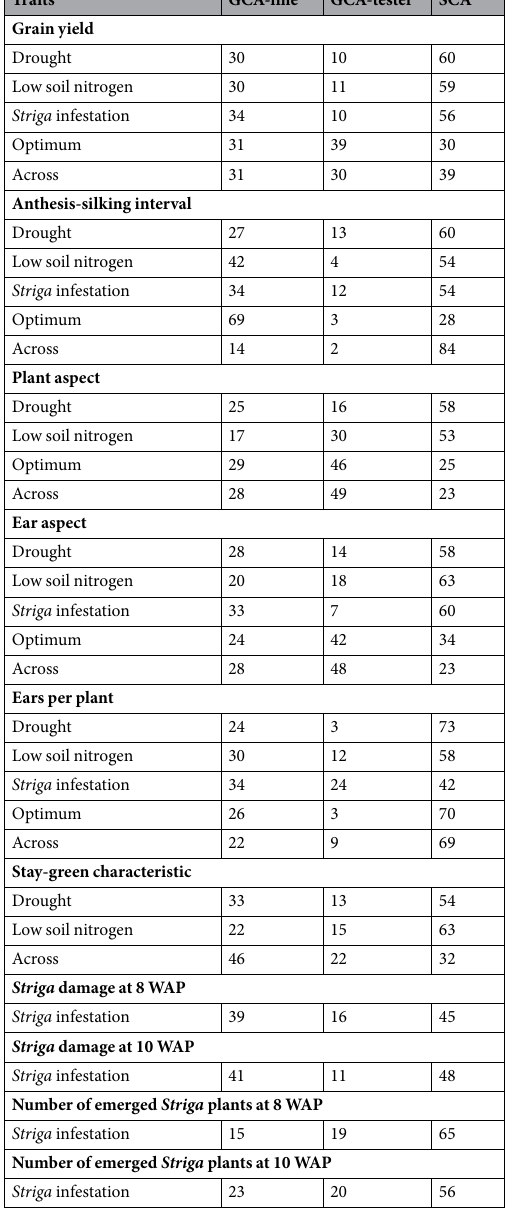
Table 4. Proportion (%) of total genotypic sum of squares of grain yield and other agronomic traits of early maturing inbred lines attributable to GCA-line, GCA-tester and SCA under drought, low soil N, optimal, Striga - infested and across the four management